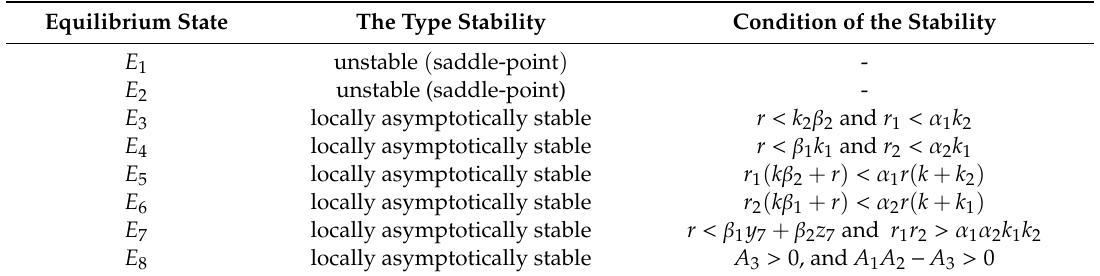
Table 2. The type stability and stability condition of all of the equilibrium states Equilibrium State The Type Stability Condition of the Stability E 1 unstable ( saddle-point ) - E 2 unstable